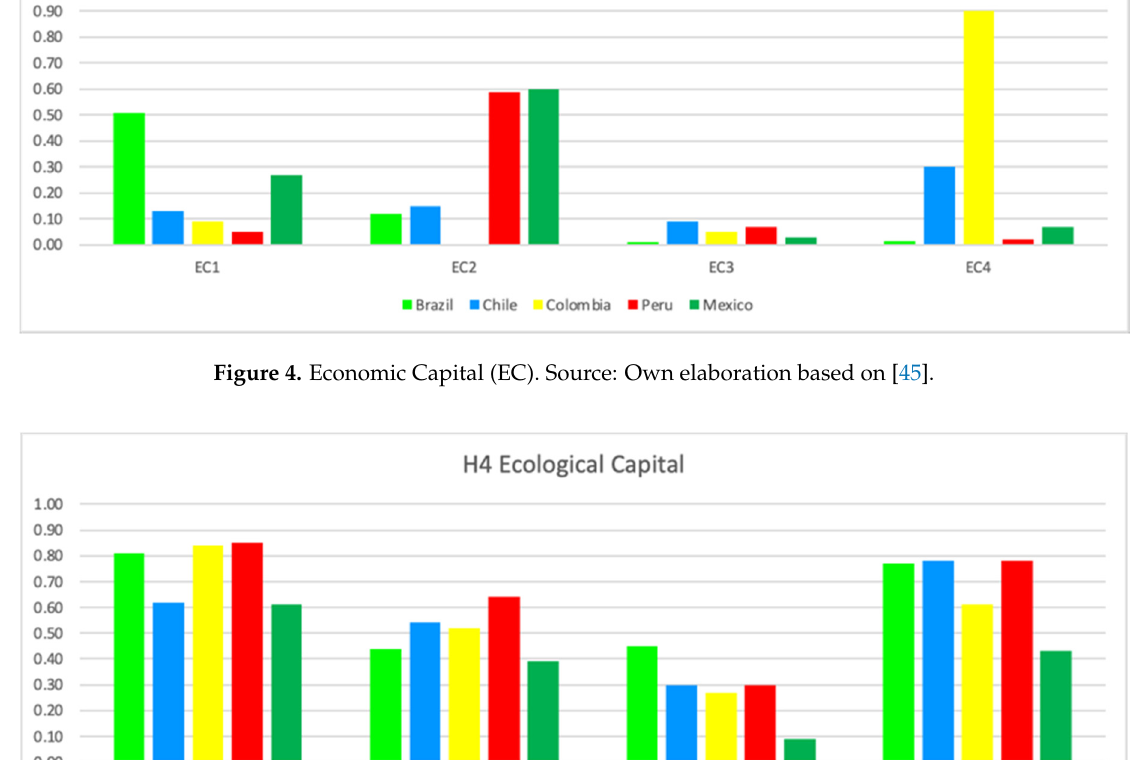
Figure 4. Economic Capital (EC). Source: Own elaboration based on [45].